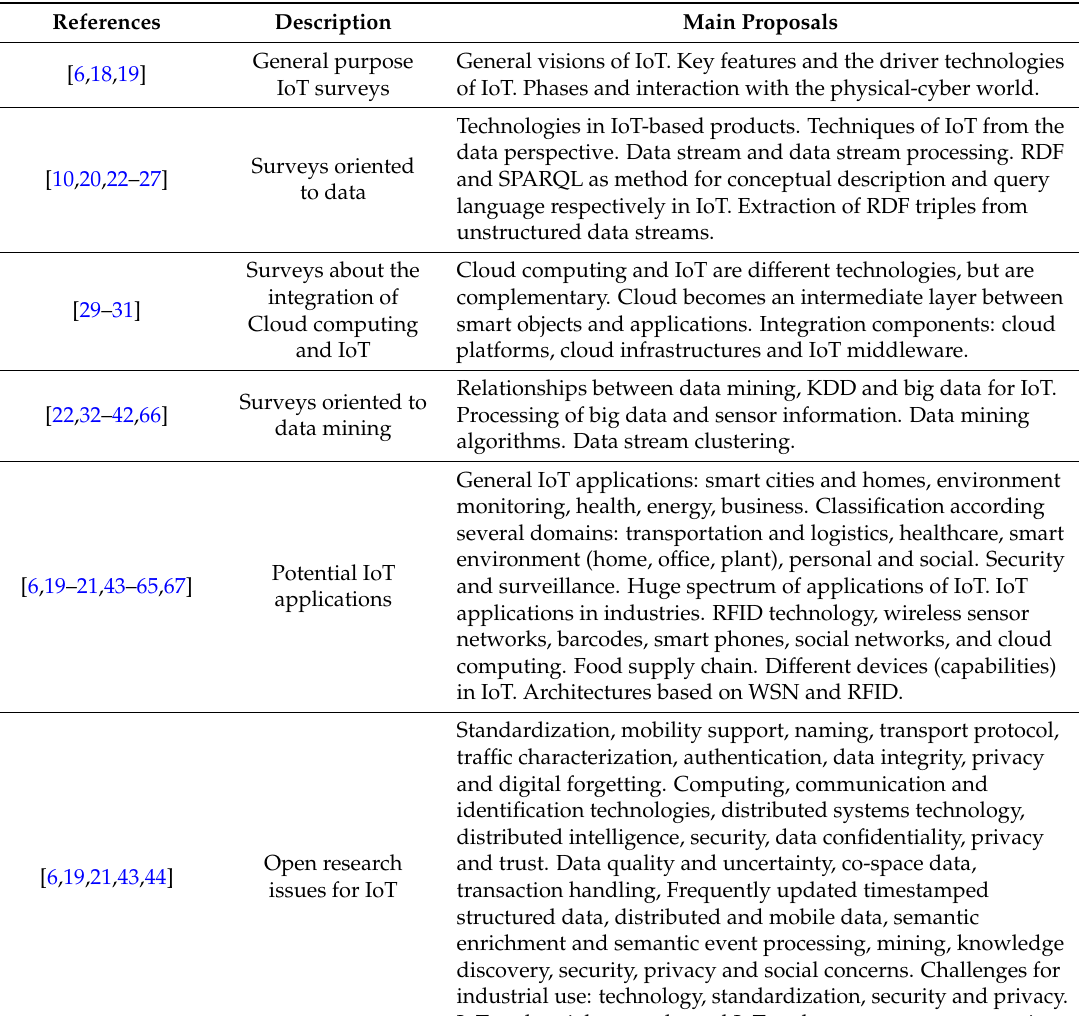
Table 2. Summary of